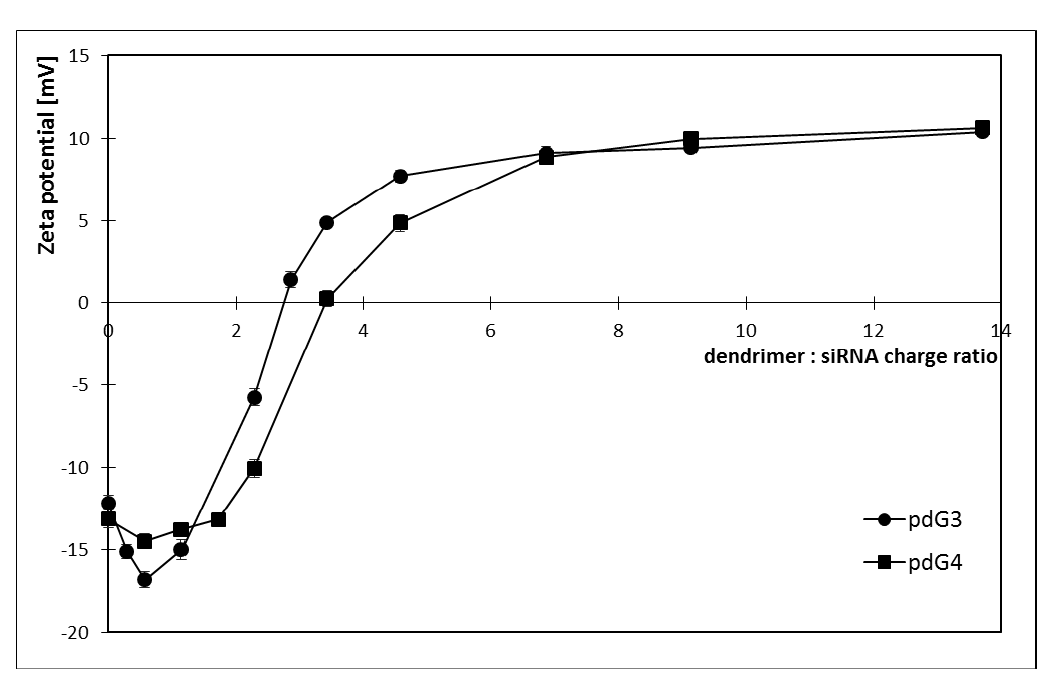
Figure 5. Changes in the zeta potential of dendriplexes formed by siRNA